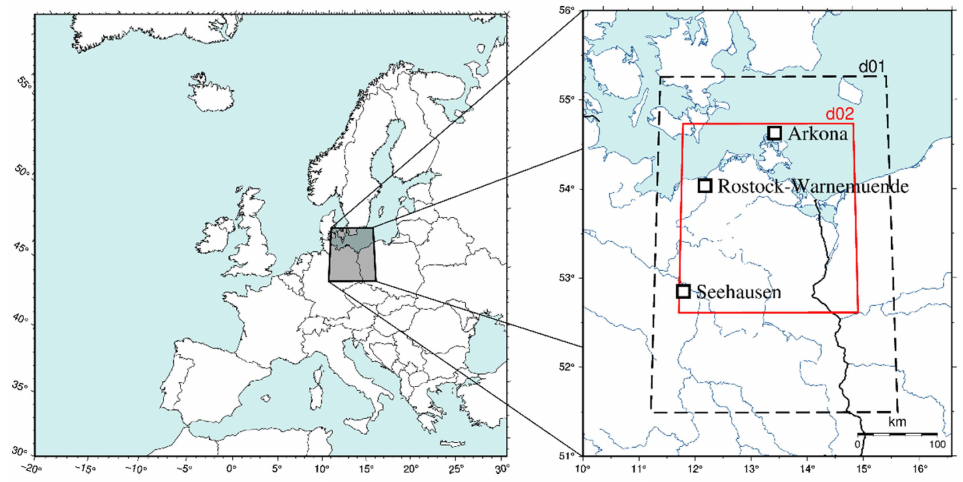
Figure 5. Overview map of the study area with marked DWD stations and the domains used in WRF.